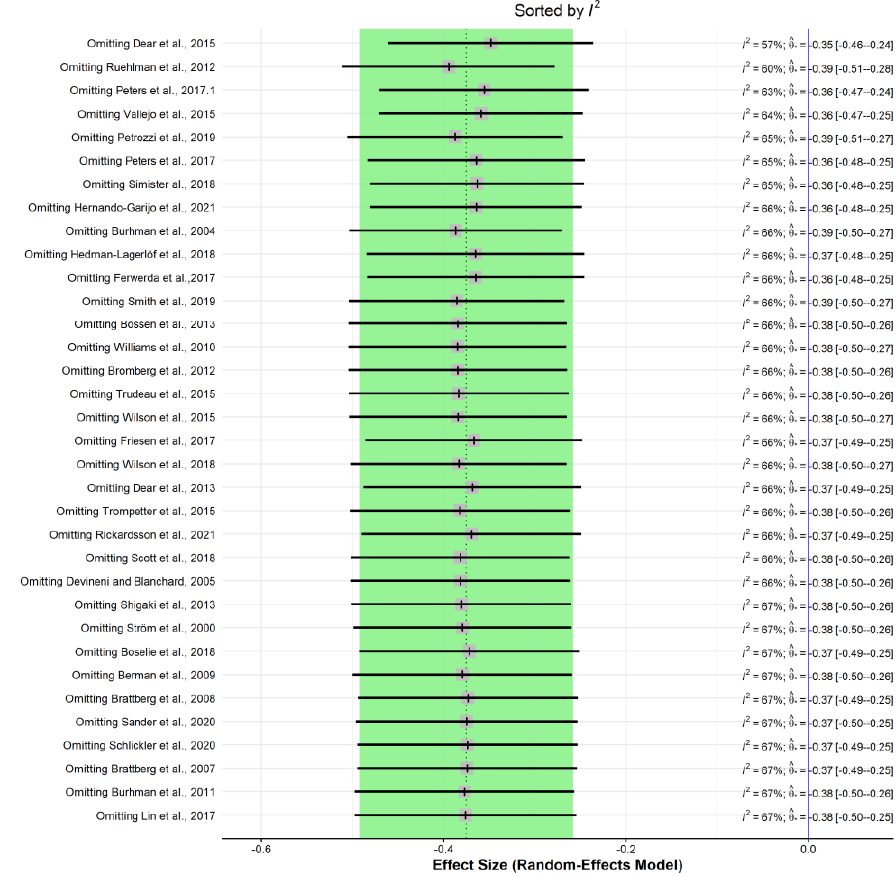
Figure A5. Leave-one-out figure of all the studies.